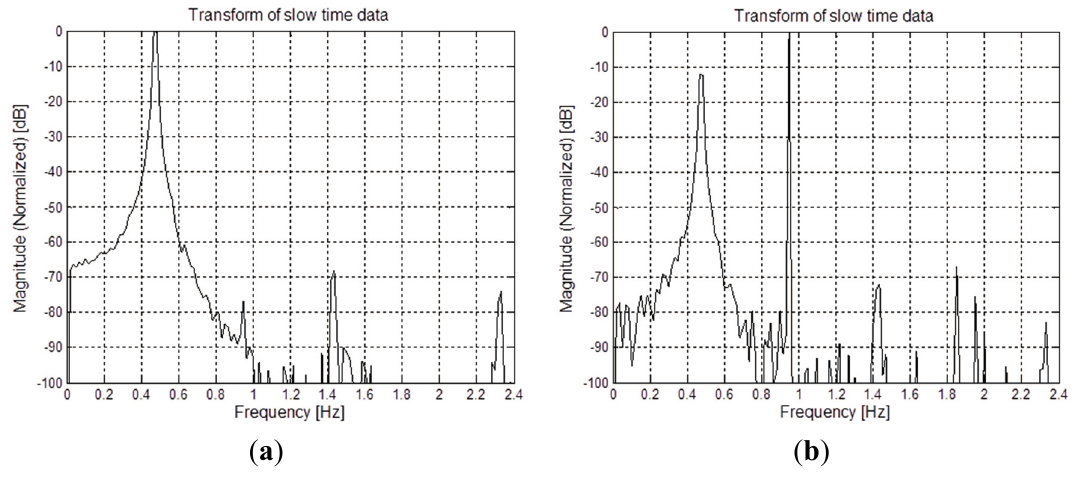
Figure 13. Example of breath rate detection through FFT. ( a ) In the case of (almost) correct τ 0 estimate; ( b ) In the case of incorrect τ 0